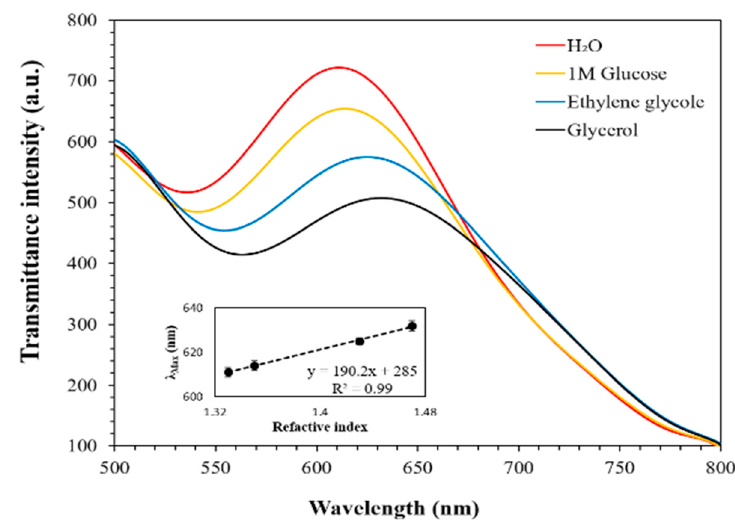
Figure 2. Transmittance LSPR peak wavelength shows red-shift response as observed in H 2 O (n = 1.33), 1 M glucose (n = 1.35), ethylene glycol (n = 1.43) and glycerol (n = 1.47) and individual wavelength shifts over the refractive index reveal the average sensitivity of the fabricated plasmonic device.